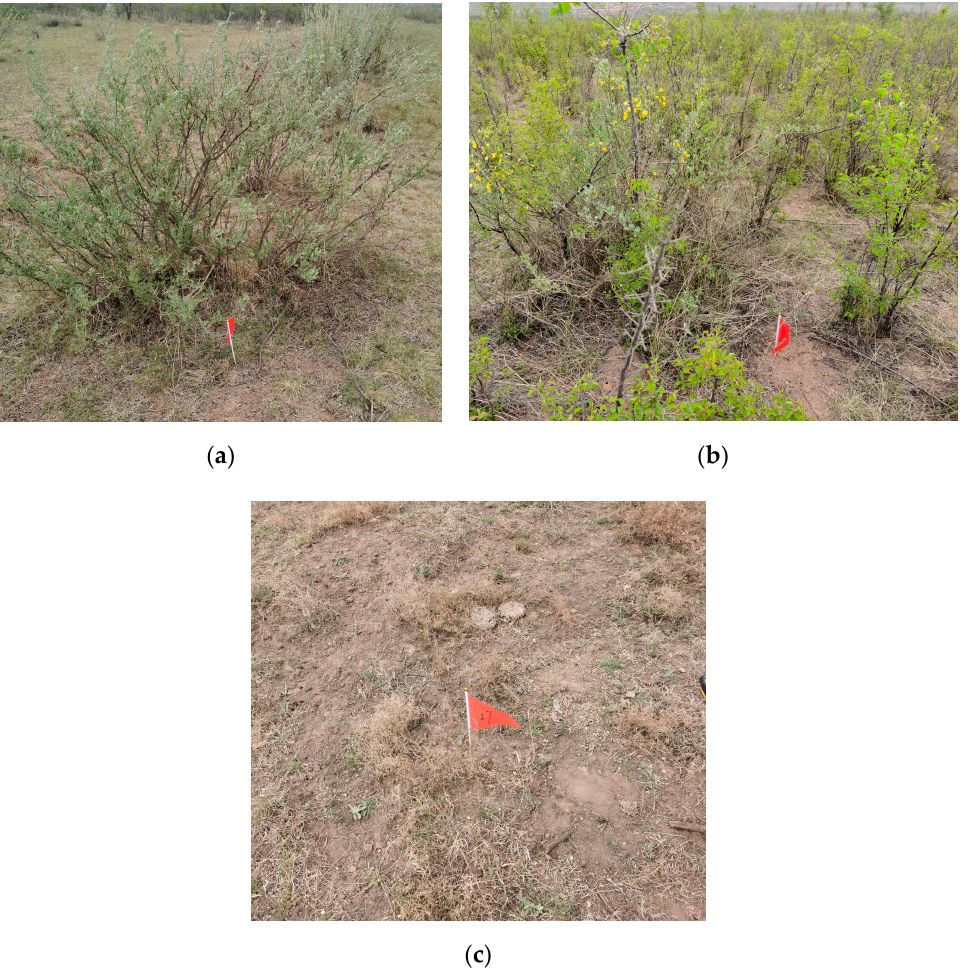
Figure 6. The pictures for ( a ) Sophora davidii, ( b ) Siberian almond tree and ( c ) sparse grass in the study area. Table 2. Statistical metrics of the downscaled SMs derived from 1 km SPL2SMAP_S SM product.